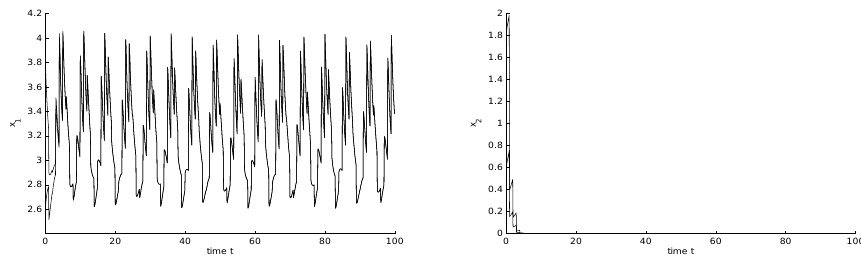
Figure 3: System (1.3) with ( ϕ 1 ( t ), ϕ 2 ( t )) = (3.8, 0.6) T and (2.6, 1.8) T for t ≤ 0 respectively.